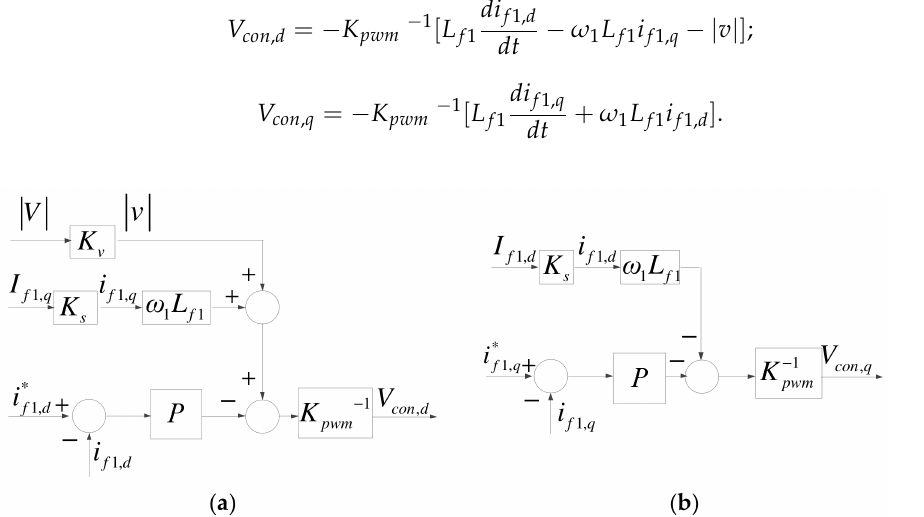
Figure 7. Grid inverter inner-loop current controllers: ( a ) d axis; ( b ) q axis.